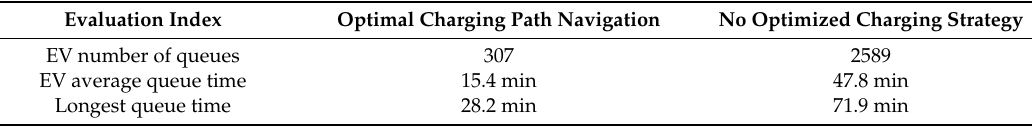
Table 2. Comparison of charging queue length of electric vehicle.